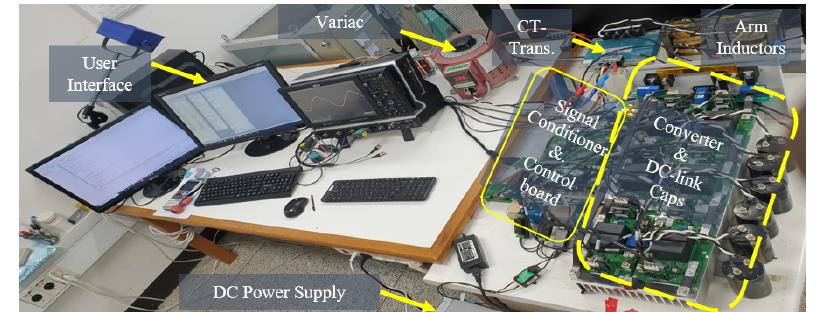
Figure 10. Experiment setup.